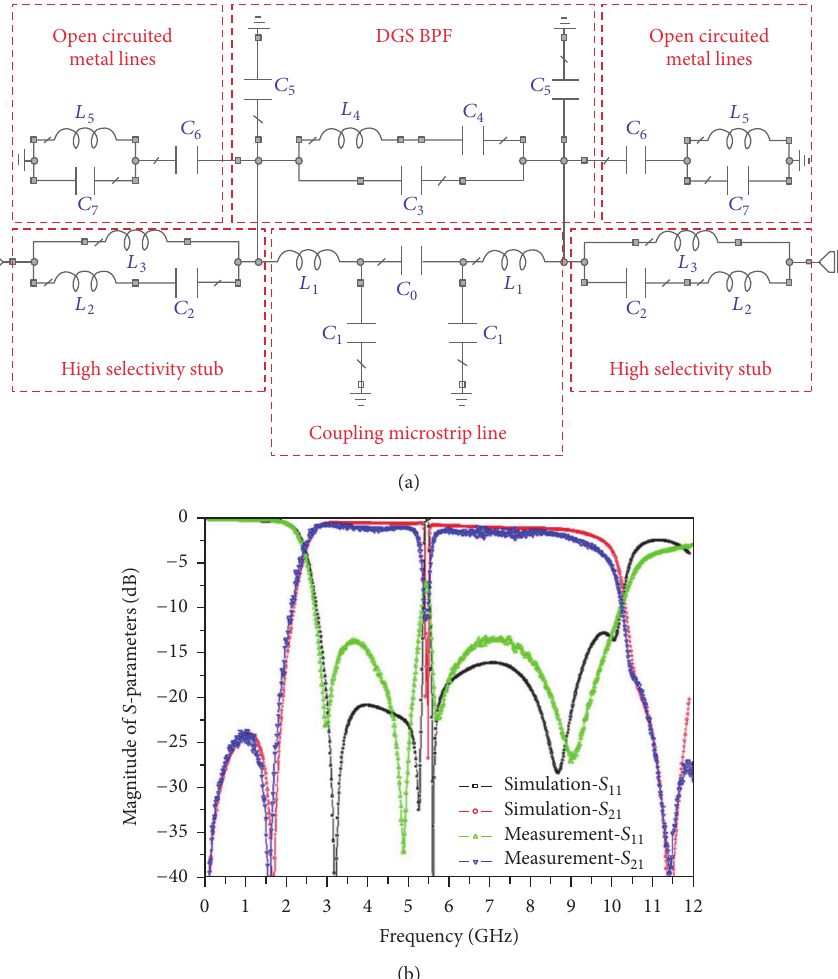
Figure 19: (a) Equivalent circuit of the UWB BPF with notch band implementation; (b) 𝑆 -parameter response [58].